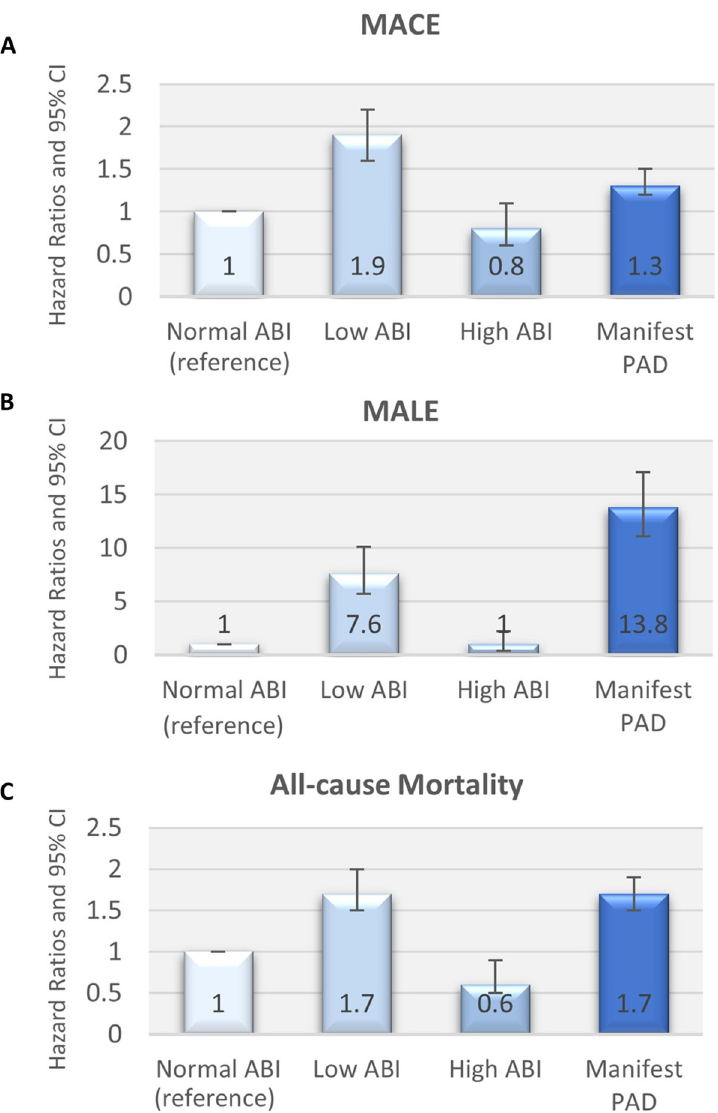
Fig 3. Adjusted Hazard Ratios of screen-detected abnormal ABI & manifest PAD patients for MACE (A), MALE (B), and all-cause mortality (C) according to Model 3. Model 3 was adjusted for age, sex, smoking, non-HDL cholesterol, systolic blood pressure, renal function, and diabetes mellitus status. Abbreviations: ABI = ankle brachial index, PAD = peripheral arterial disease.